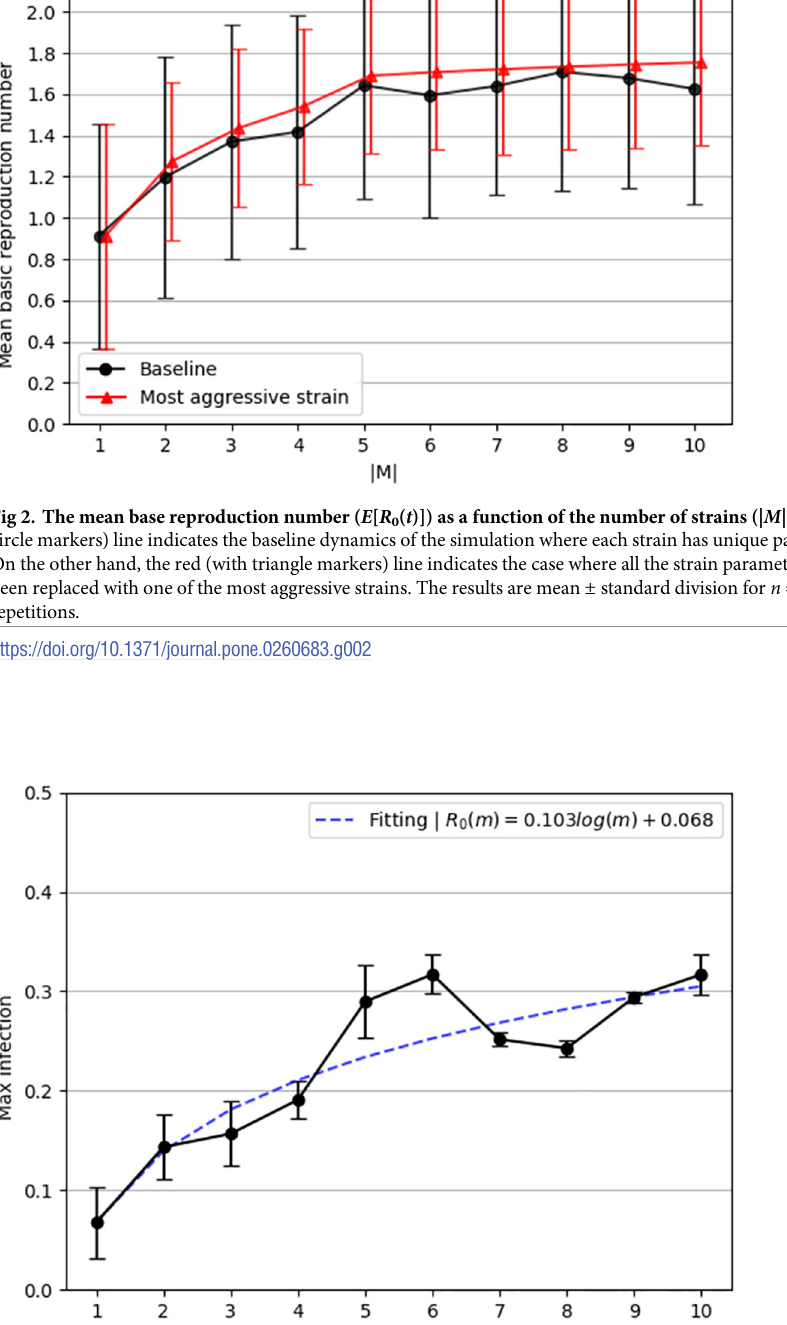
PLOS ONE | https://doi.org/10.1371/journal.pone.0260683 April 28,